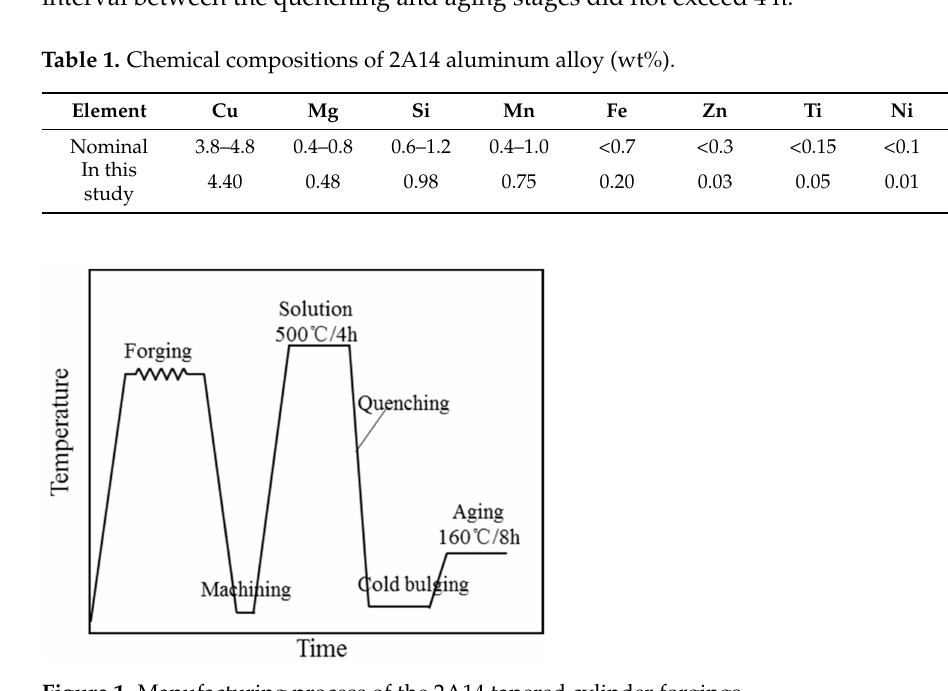
Figure 1. Manufacturing process of the 2A14 tapered cylinder forgings.